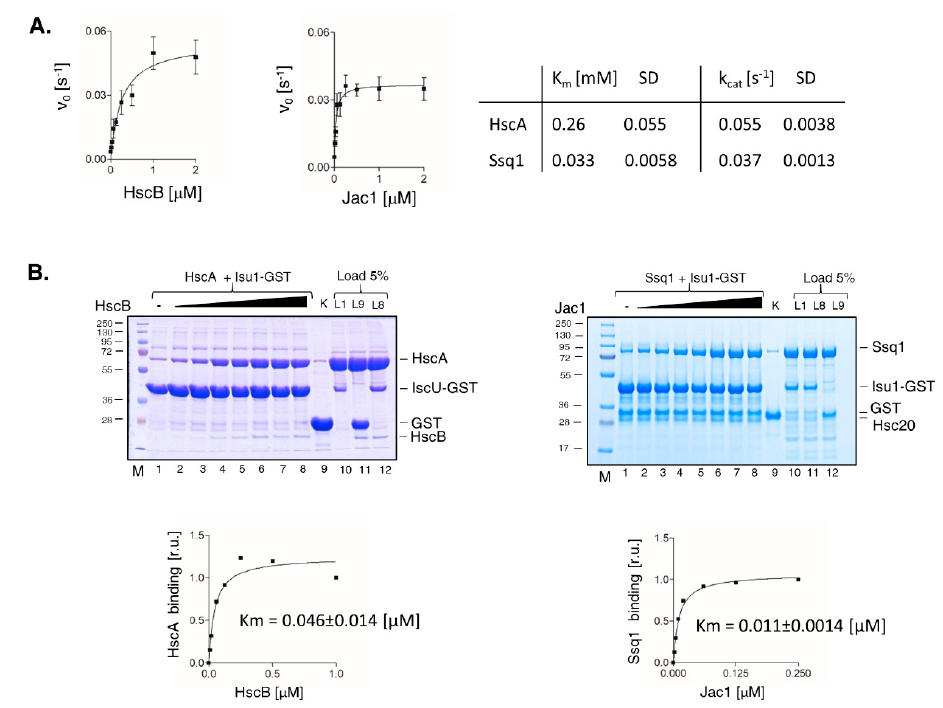
Figure 4. A ffi nity of HscA / Ssq1 for HscB / Hsc20 cochaperones. ( A ) Stimulation of HscA / Ssq1 ATPase activity at increasing concentrations of cochaperones. ATPase activities were measured with radioactive assay as described in Figure 2B but with increasing concentrations of HscB or Hsc20, as indicated. Curves represent best fit of the data to the Michaelis-Menten equation. Error bars represent SD for three independent measurements. ( B ) Stimulation of HscA / Ssq1 interaction with IscU / Isu1-GST in the presence of cochaperones and ATP. ( left ) IscU-GST (30 µ M) was incubated with HscA (30 µ M) in the presence of ATP (4 mM) and increasing concentrations of HscB (0.01; 0.02; 0.06; 0.125; 0.25; 0.5; 1 µ M). Glutathione resin was added to pull-down GST and associated proteins, which were separated by SDS-PAGE and stained with Coomassie Blue. Lane 9: a control where IscU-GST was replaced by GST and 1 µ M HscB + 30 µ M HscA were present in the reaction mixture (“K”). Lanes 10-12: Five percent of the reaction mixtures that were run in lanes 1, 9 and 8, were run as loading control (Load 5%: L1, L9, L8). M: lane having molecular weight markers. Bound HscA was quantitated by densitometry. Values were plotted as relative units (r.u.) with maximal signal for HscA set at 1. Curve represent best fit of the data to the Michaelis-Menten equation. ( right ) Isu1-GST (2.5 µ M) was incubated with Ssq1 (4 µ M) in the presence of ATP (4 mM) and increasing concentrations of Hsc20 (0.0025; 0.005; 0.01; 0.02; 0.06; 0.125; 0.25 µ M). Glutathione resin was added to pull-down GST and associated proteins, which were separated by SDS-PAGE and stained with Coomassie Blue. Lane 9: control where Isu1-GST was replaced by GST and 0.25 µ M Hsc20 + 4 µ M Ssq1 were added to the reaction mixture (“K”). Lanes 10–12: Five percent of the reaction mixtures run in lanes 1, 8 and 9, were run as loading controls (Load 5%: L1, L8, L9). M: lane having molecular weight markers. Bound Ssq1 was quantitated by densitometry. Values were plotted as relative units (r.u.) with maximal signal for Ssq1 set at 1. Curve represent best fit of the data to the Michaelis-Menten